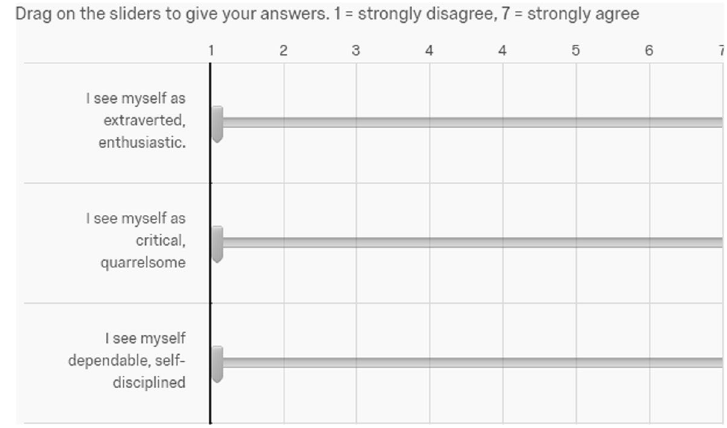
Fig. 3 Snapshot of TIPI in Our Questionnaire